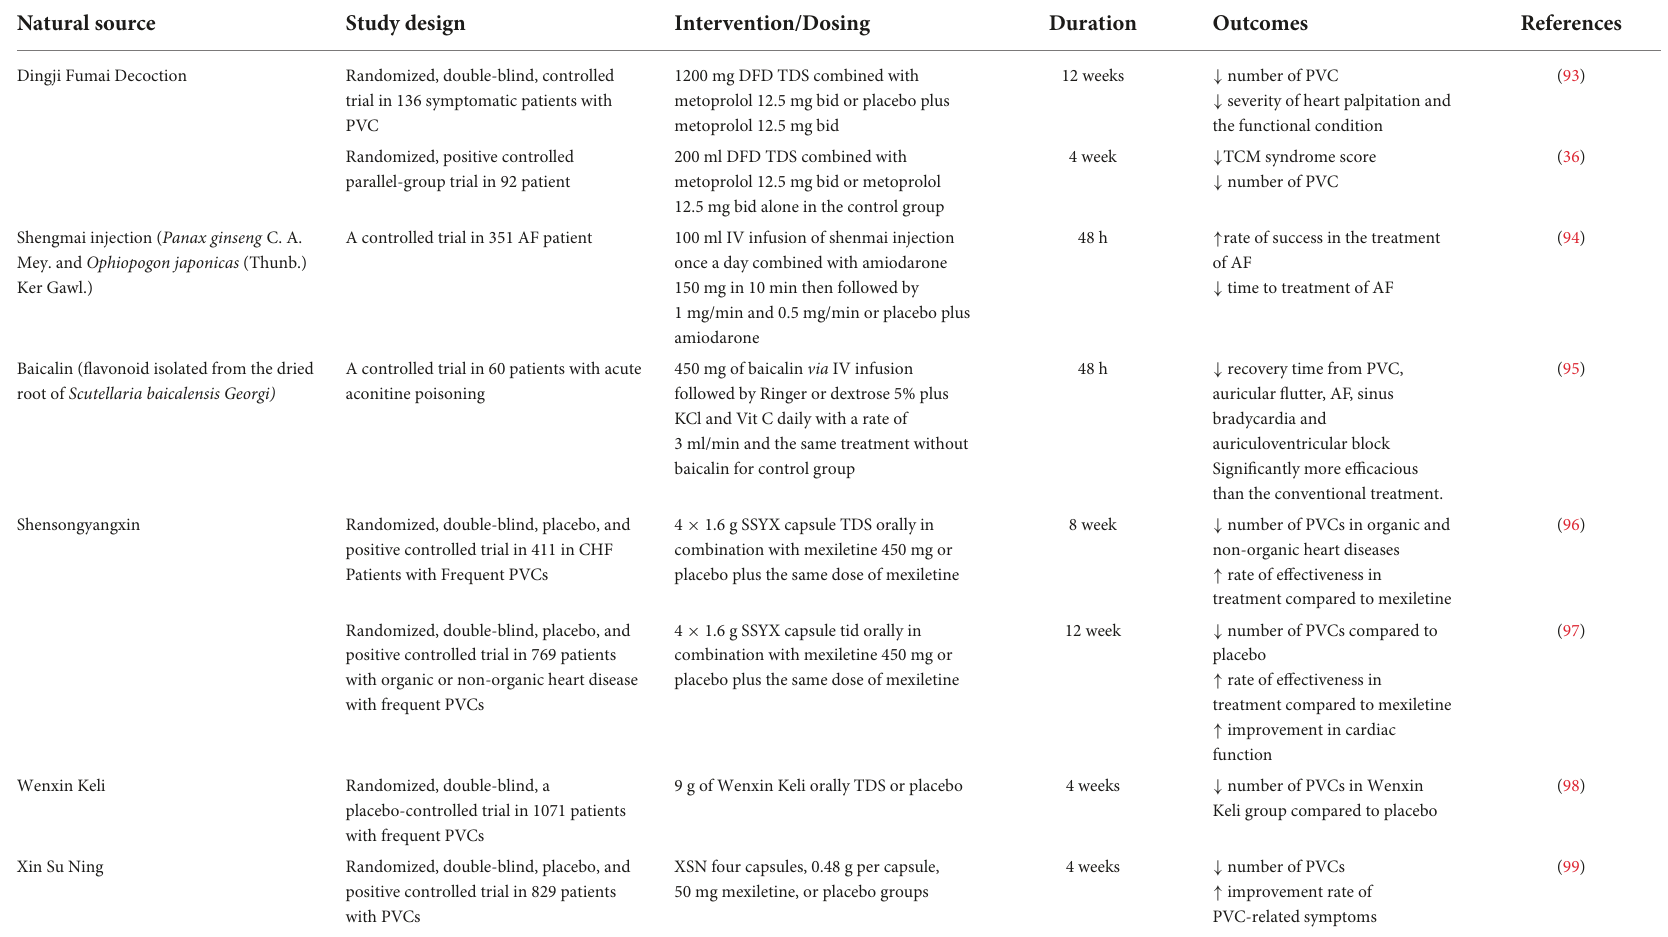
TABLE 4 Summary of the clinical studies investigating the efficacy and safety of phytochemicals or multi-component herbal preparations on cardiac